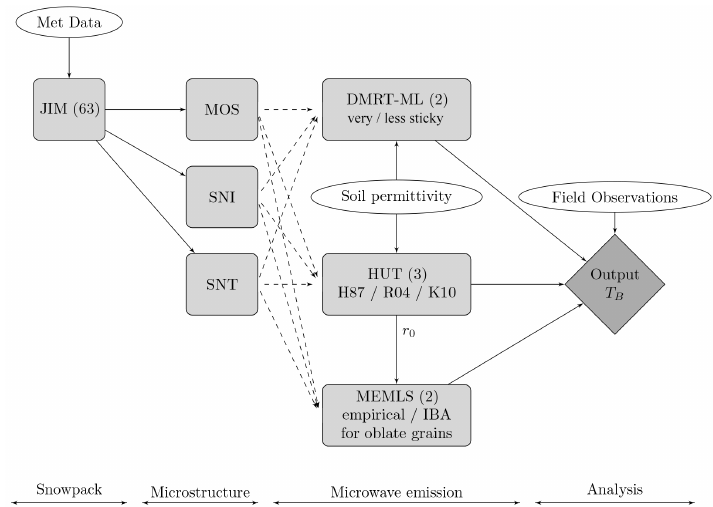
Figure 1. Flowchart showing flow of information from JIM snow evolution model outputs to outputs from the various microwave emission models. Table 2. Electromagnetic model inputs, as a function of JIM snowpack model outputs. JIM DMRT-ML MEMLS HUT output input input input Temperature T JIM [K] T JIM [K] T JIM [K] T JIM − 273 . 15 [ ◦ C] Density ρ JIM [kgm − 3 ] ρ JIM [kgm − 3 ] ρ JIM [kgm − 3 ] ρ JIM [gcm − 3 ] 1000 Layer size (cid:49)z JIM [m] (cid:49)z JIM [m] (cid:49)z JIM [cm] ρ JIM (cid:49)z JIM [mm swe ] 100 [mm] Microstructure d JIM 1000 Layer number Soil permittivity (cid:15) obs r 0 , HUT (cid:15)